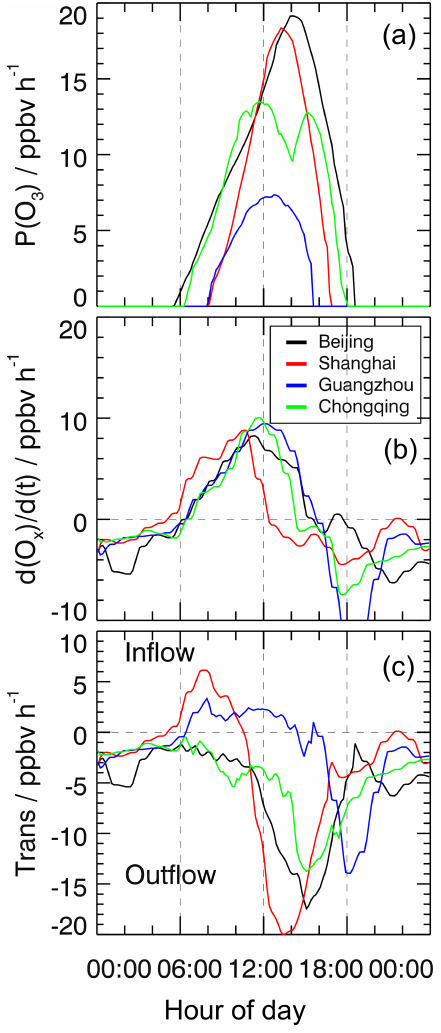
Figure 9. In situ ozone budget analysis in four cities. Panel (a) denotes the local ozone production rate P (O 3 ) derived from the model calculation. Panel (b) denotes the derivatives of the observed O x concentrations d(O x ) / d( t ). Panel (c) denotes the difference be- tween P (O 3 ) and d(O x ) / d( t ), which indicates the effect of local chemical production on transportation (see